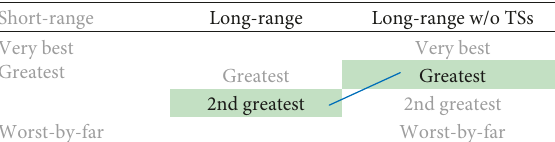
Table 10: Tabular representation of Rule 1.